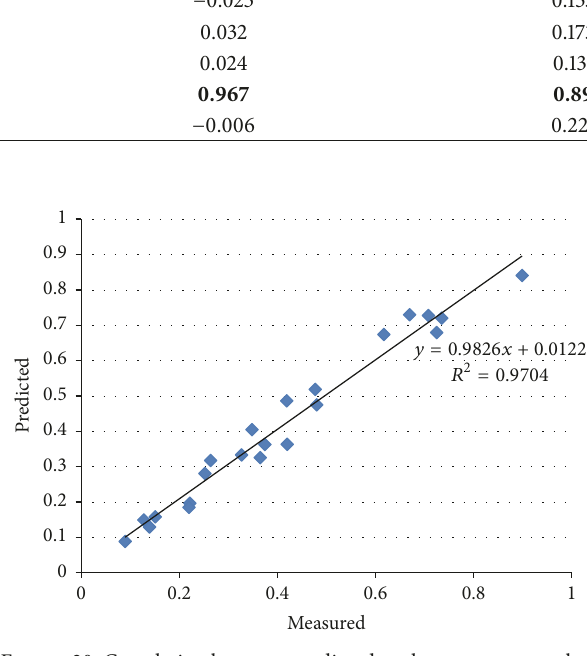
Figure 18: Correlation between predicted settlements versus calcu- lated ones for the best static neural network, 5-3-12-1.